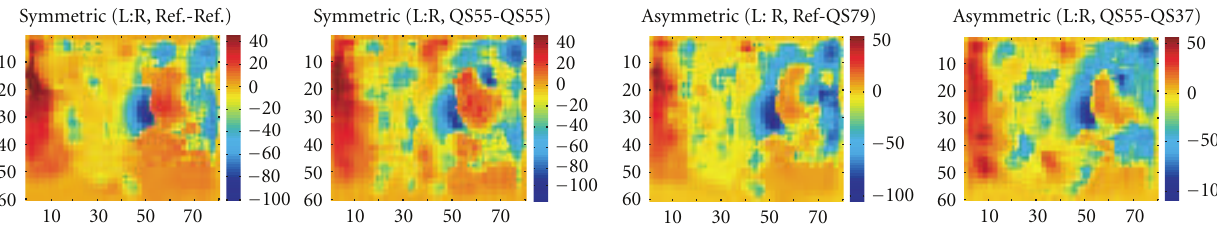
Figure 10: Depth maps of distinct symmetric and asymmetric pairs for Cattle